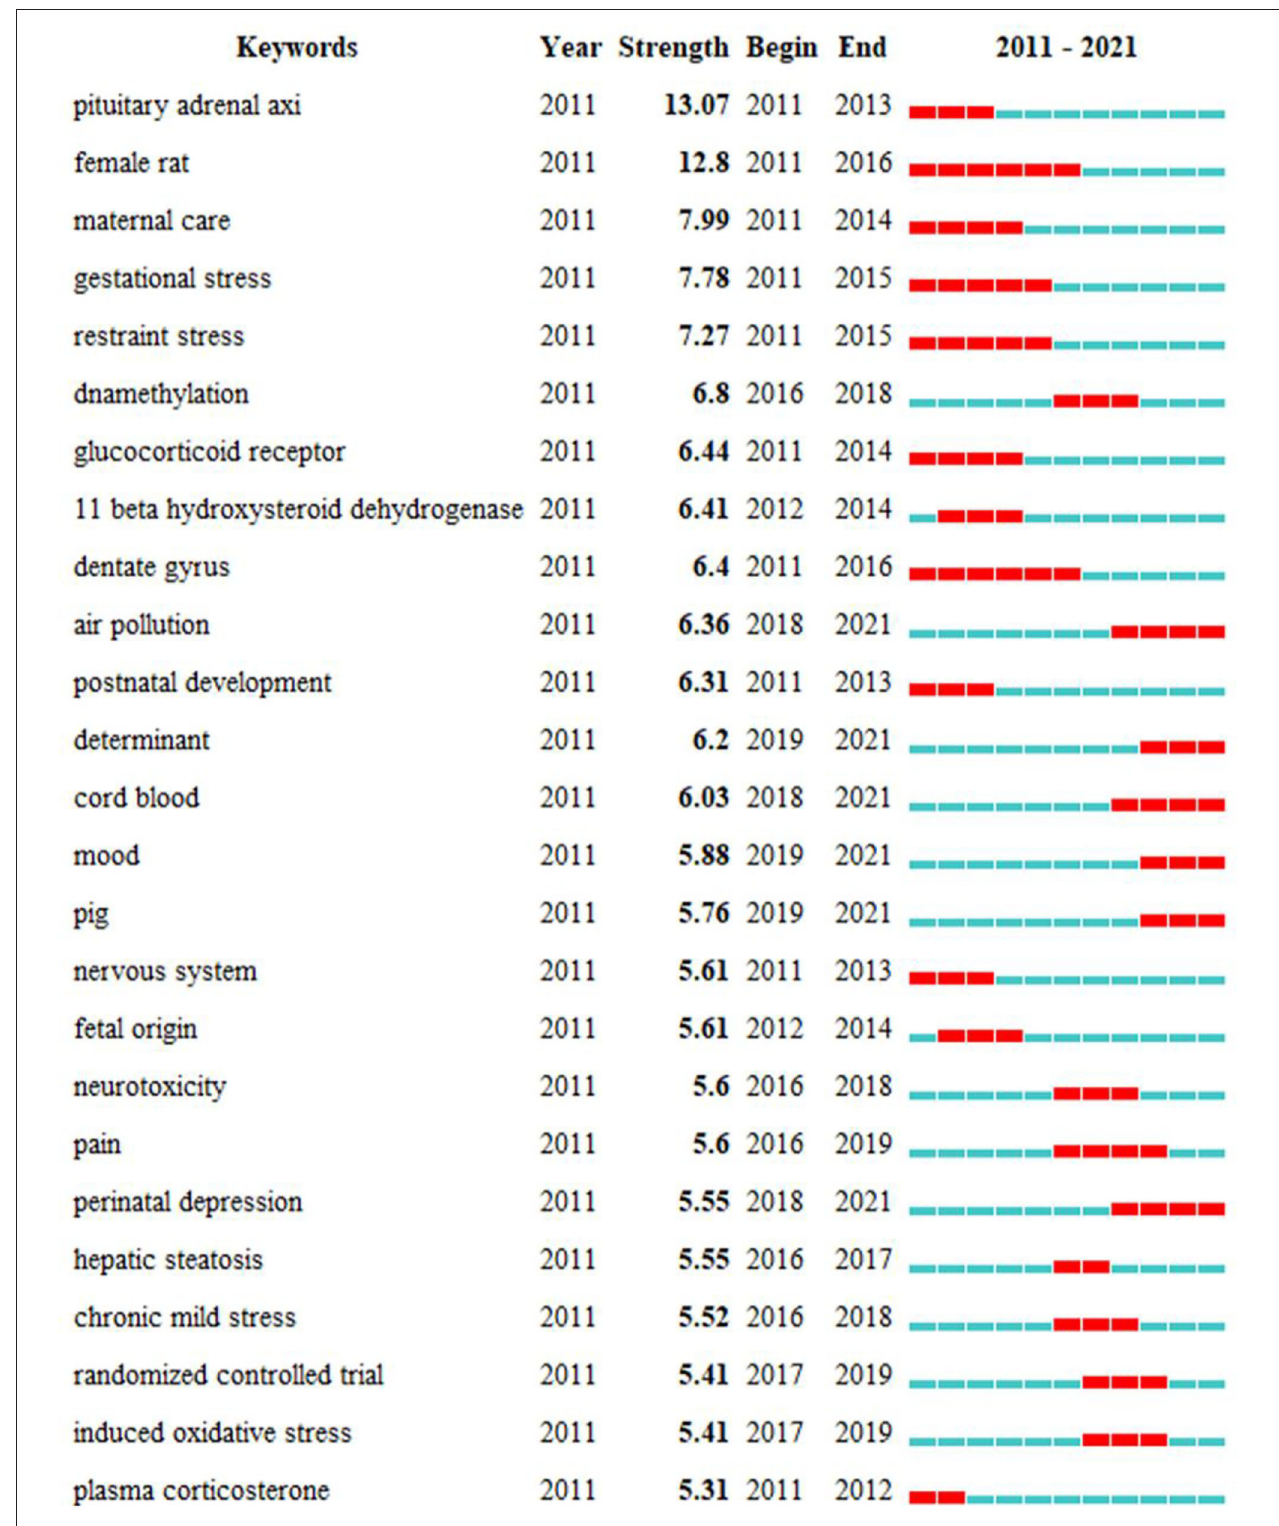
FIGURE 8 | Top 25 representative burst keywords.